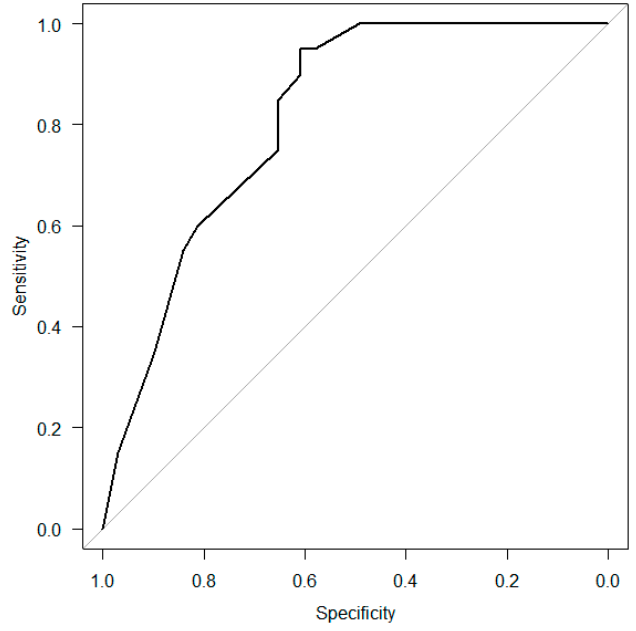
Figure 5. ROC curve analysis on the combined variables “Age above 75”, “Causative diseases”, “Low MTP value (6 h)”, and “Low MTP value (24 h)”. The AUC value was 0.81 (95% CI: 0.73–0.90). Table 4. A new population excluding the confounding factors was created using the pair-matching analysis. A total of 40 cases, 20 in each in of the two groups, was selected for the analysis. Age Normal